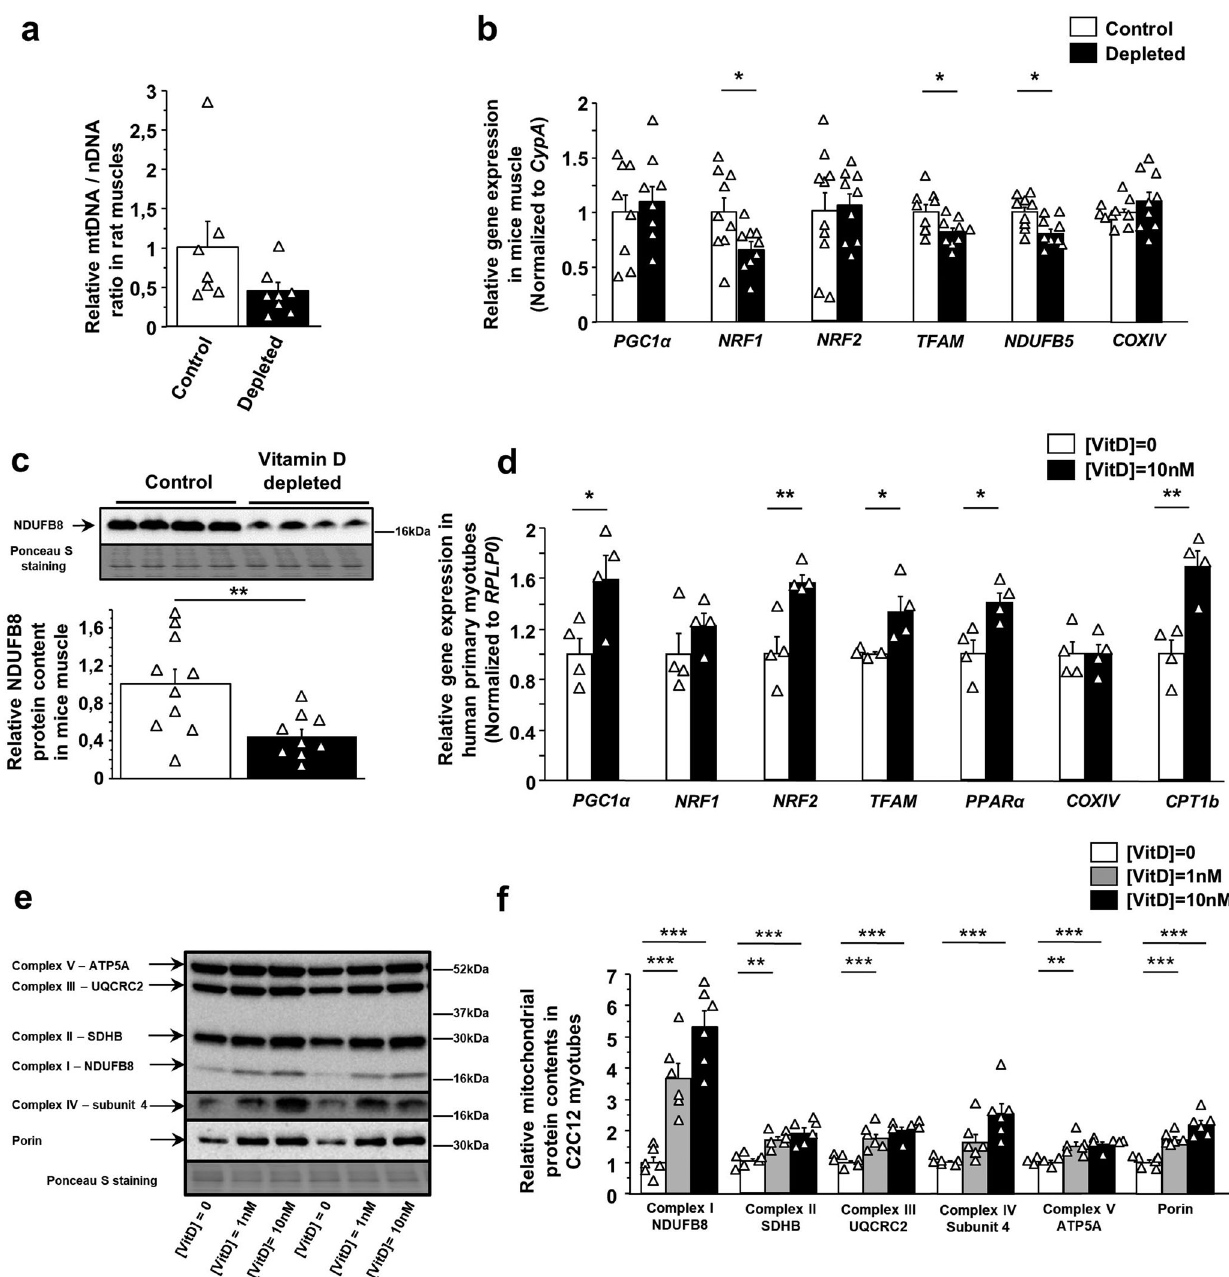
Fig. 3 Vitamin D in fl uences mitochondrial protein content and gene expression patterns in skeletal muscles, C2C12 and human primary myotubes. a mtDNA/nDNA ratio as a marker of mitochondria content in plantaris muscles from vitamin D-depleted old rats ( n = 8) and control old rats ( n = 7). b Transcript levels of genes involved in mitochondrial biogenesis and function, and c protein content of NDUFB8, a respiratory chain complex I subunit, in gastrocnemius muscle from vitamin D-depleted old mice ( n = 9) and control old mice ( n = 8 – 10) (Mouse experiment 1). mRNA levels were normalized to the housekeeping gene CypA . d Transcript levels of genes involved in mitochondrial biogenesis and function in human primary myotubes treated with 0 and 10 nM of 1,25(OH)2 vitamin D3. mRNA levels were normalized to the housekeeping gene RPLP0 . Representative immunoblots and red Ponceau staining ( e ), and immunoblot quanti fi cations ( f ) of several subunits of each mitochondrial complex and Porin protein in C2C12 myotubes treated with 0 and 10 nM of 1,25(OH)2 vitamin D3. Cell culture data are combined from at least two independent experiments ( n = 4 – 6). Data are expressed as means ± SEM and as fold change vs. control-group value. Differences between groups were analyzed with an unpaired t -test for rat and cell studies and with the Mann – Whitney U -test for mouse experiment 1. *statistically different from control animals or cells at p < 0.05. **statistically different from control animals or cells at p < 0.01, ***statistically different from control animals or cells at p < contraction, translation elongation, ribosomes, and cytosol (Sup- enriched in annotations associated with purine metabolism, plementary Figure 2a). Functional enrichment analysis fi ltered with sarcoplasmic reticulum membrane, and mitochondria (Fig. 4a). In only the top 10 annotations for Gene Ontology BP, CC, KEGG, and particular, DAVID analysis indicated that 51 downregulated DEGs Reactome components revealed that downregulated DEGs were were signi fi cantly enriched in a GO term related to mitochondria